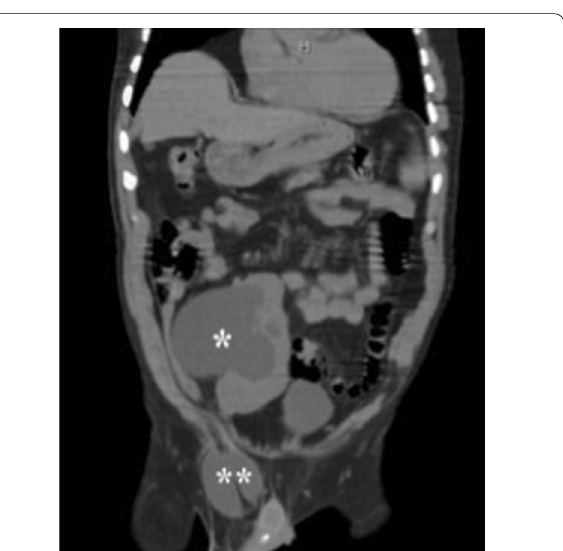
Fig. 3 Coronal section of the CTU, showing a poorly rotated solitary pelvic kidney. * Solitary pelvic kidney, with herniation of the right ureter through the right inguinal canal, “loop the loop” sign. ** Right inguinal